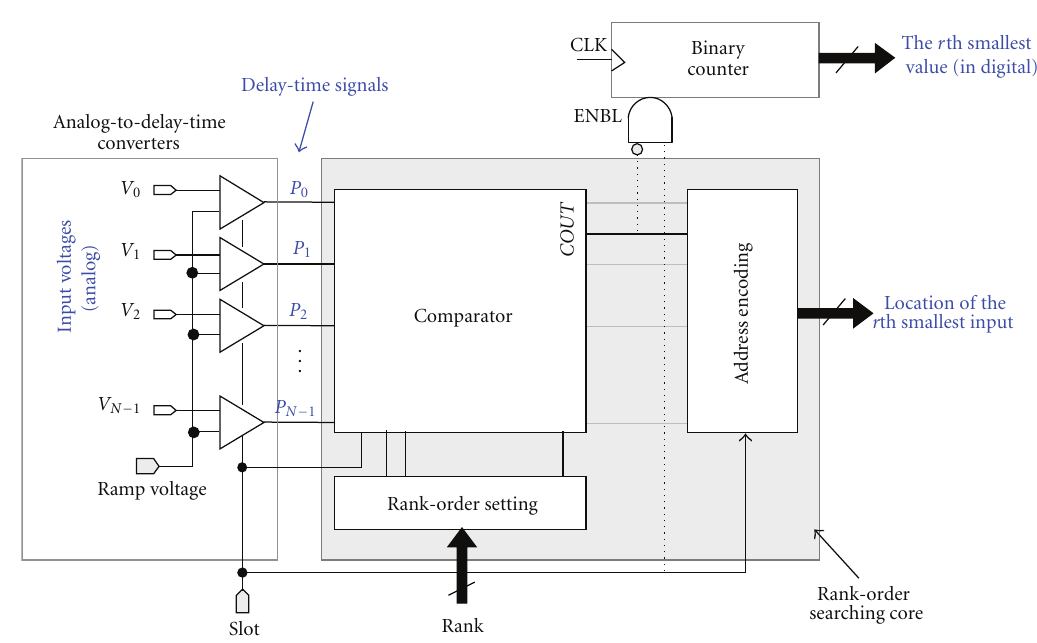
F 1: Block diagram of the rank-order searching circuit.